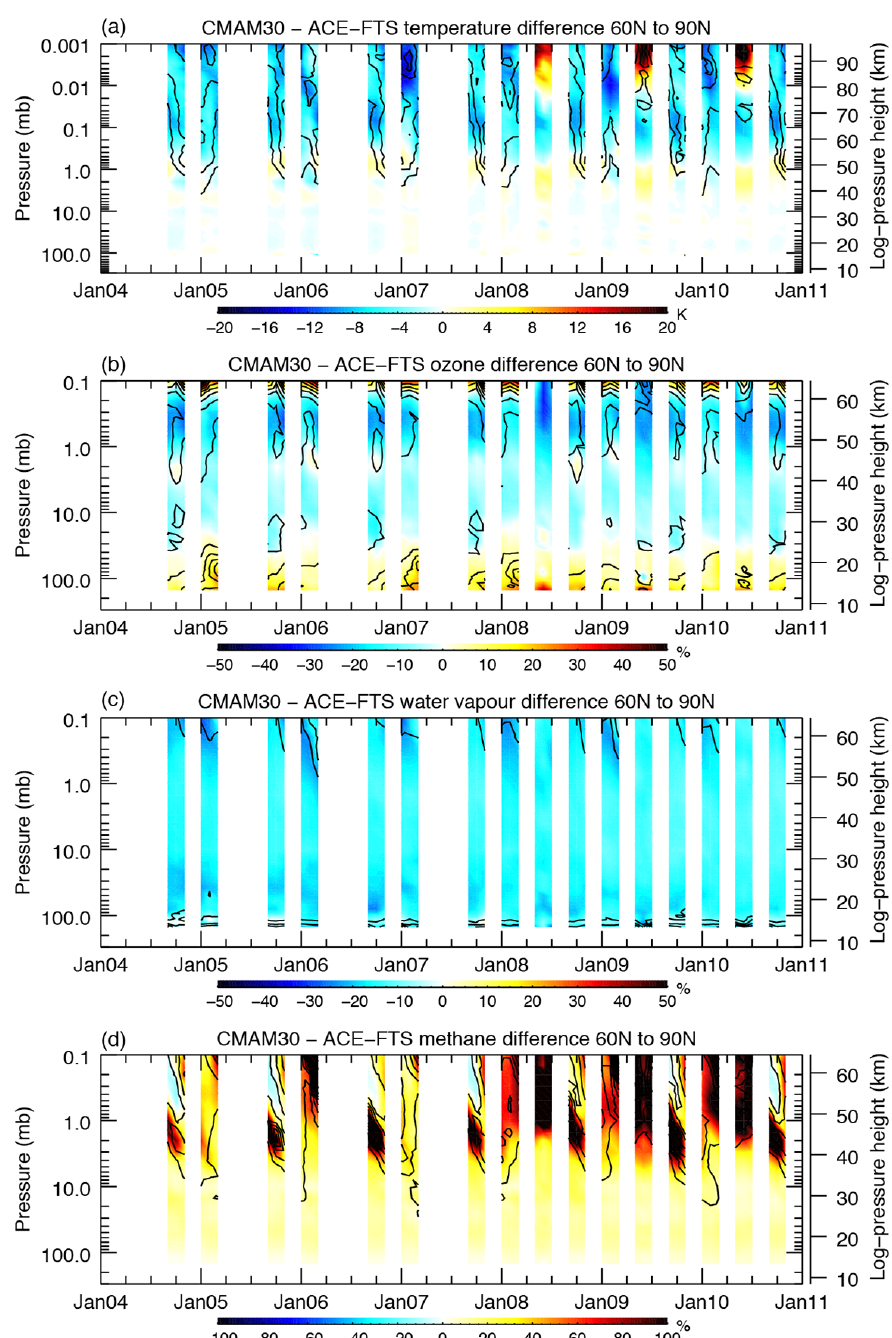
Figure 10. Same as for Fig. 9 but for 60 to 90 ◦